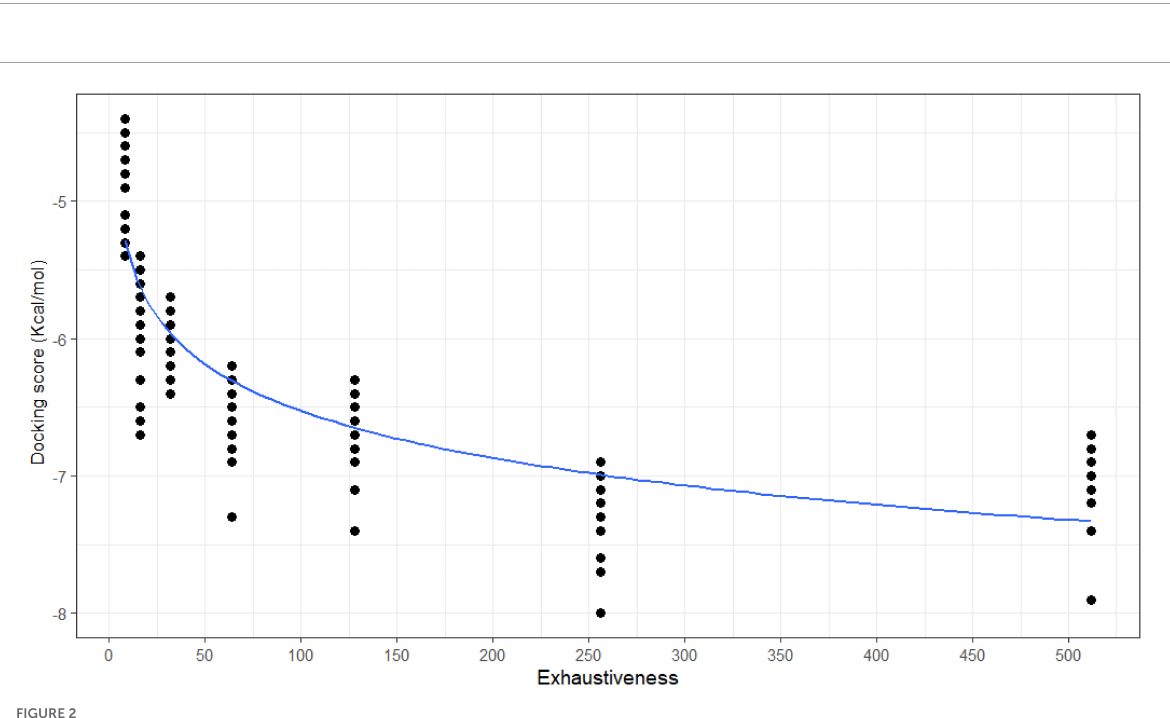
FIGURE2 The correlation between exhaustiveness values and docking scores of each 20 binding poses of the system 5C1U—Rupintrivir. The correlation was calculated and drawn by RStudio followed logarithmic trendline with R correlation coefficiency 0.881 ( p -value <